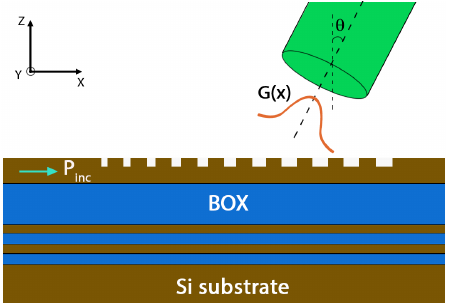
Figure 5. A typical highly efficient conventional non-uniform grating coupler. The gratings consisting of partially etched grooves with a variable fill-factor leads to maximal mode field overlap with the Gaussian fiber mode, while the underneath bottom DBR stack ensures a high